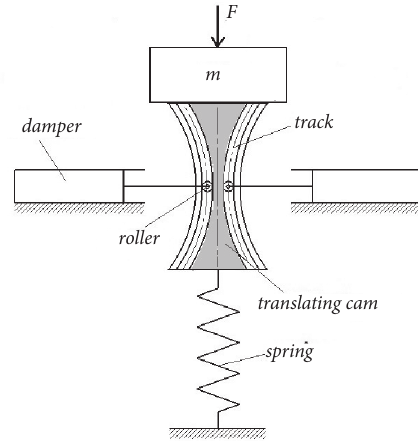
Figure 1: Schematic configuration of variable damping